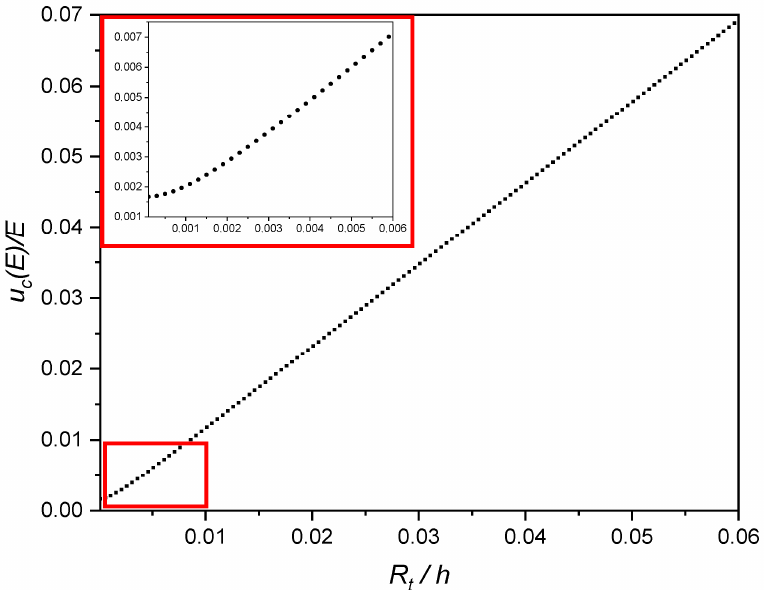
Figure 4. Trend of u c ( E ) /E vs. R t /h. In the frame the slope change for lower R t /h values is displayed.